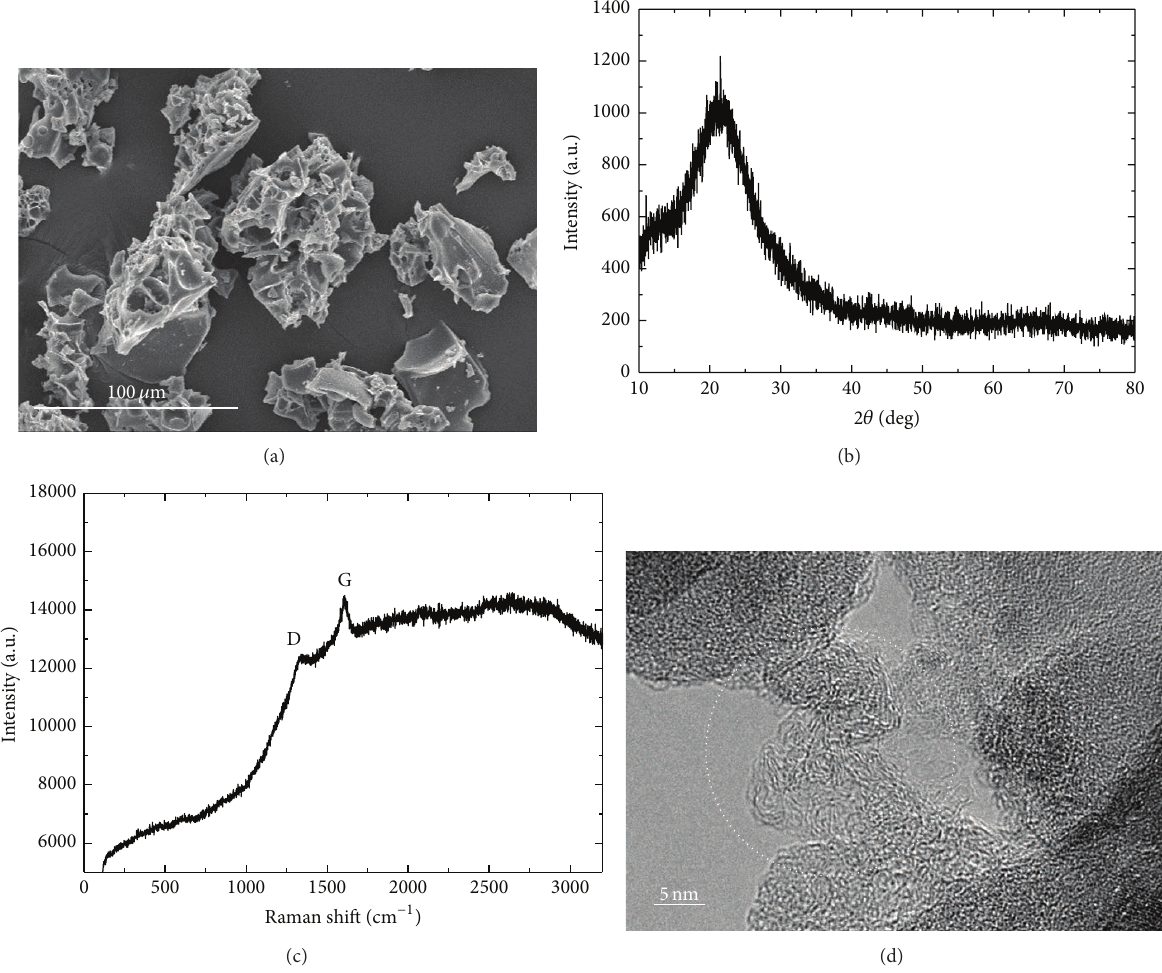
Figure 1: SEM photograph (a), XRD pattern (b), Raman spectrum (c), and (d) high resolution TEM micrograph for as-prepared powder, which was obtained by heat treatment of a sponge-like shaped material synthesized by chemical reaction of SiCl 4 with EG mixed under 1:1 volume